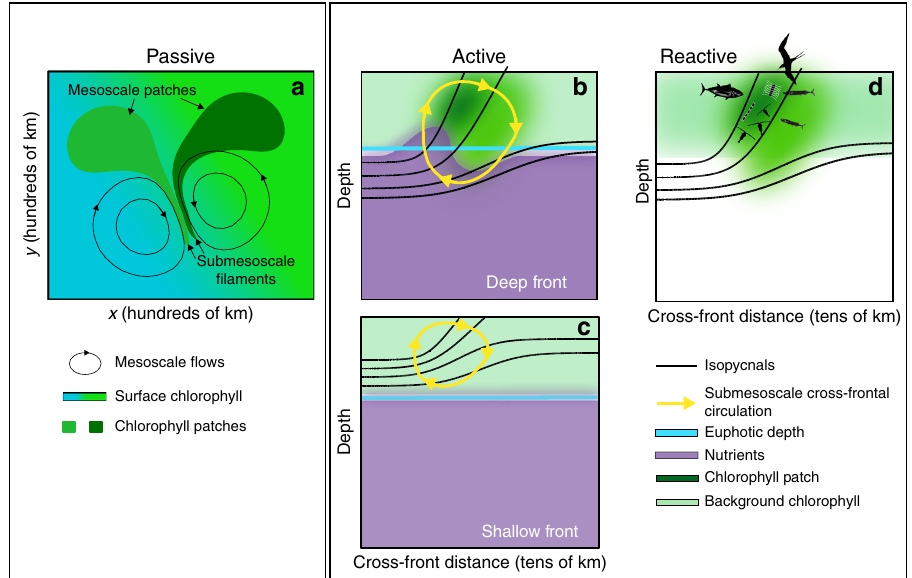
Fig. 4 Schematic representation of passive, active, and reactive mechanisms. a Passive deformations of existing phytoplankton patches by mesoscale currents can form submesoscale fi laments. b Changes in phytoplankton growth rates driven by submesoscale nutrient fl uxes into the euphotic zone can lead to the formation of phytoplankton patches at deep fronts. If the submesoscale circulations do not penetrate into the nutricline below the euphotic zone at shallow fronts, then it is unlikely that phytoplankton patches will form c . d Phytoplankton reactions (e.g., growth, competition, swimming, loss by grazing, etc.) and behavioral responses of higher trophic-level organisms (including fi sh, birds, and mammals) in response to passive and active